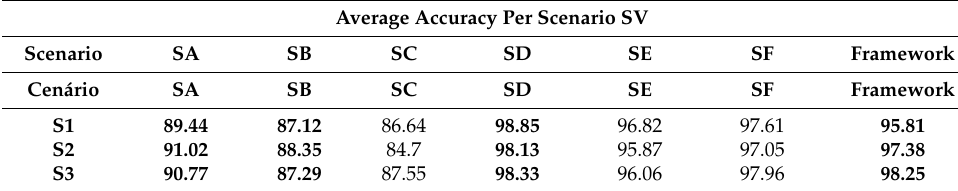
Table 10. Average accuracy per scenario SV.